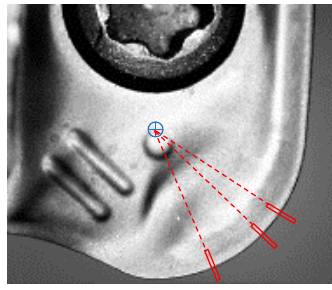
Figure 14. Pixels identification of the border on the tool nose edge on rake face images.